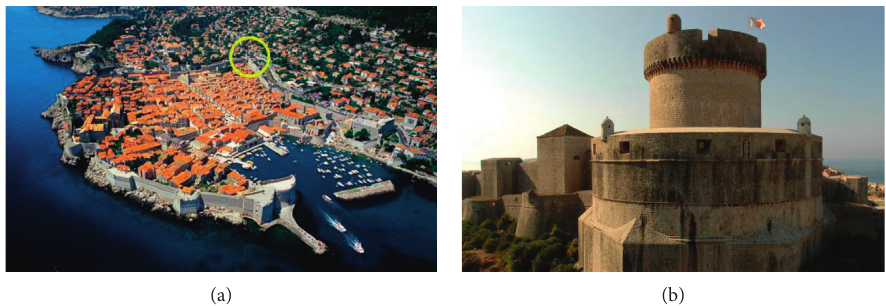
Figure 7: Dubrovnik and the Minceta fortress. (a) Dubrovnik, with the location of the Minceta fortress marked. (b) A view of the Minceta fortress from the north-west